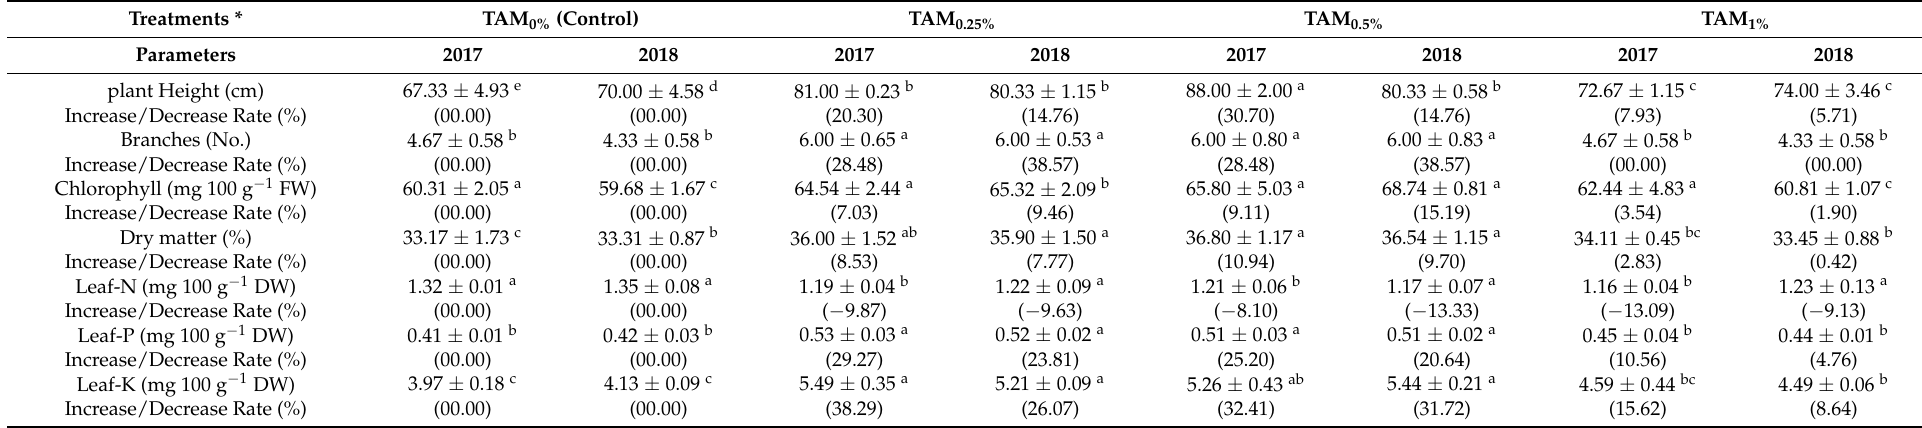
Table 4. The effect of different TAM ® levels on growth characterization of C. annuum , during 2017 and 2018 growing seasons.